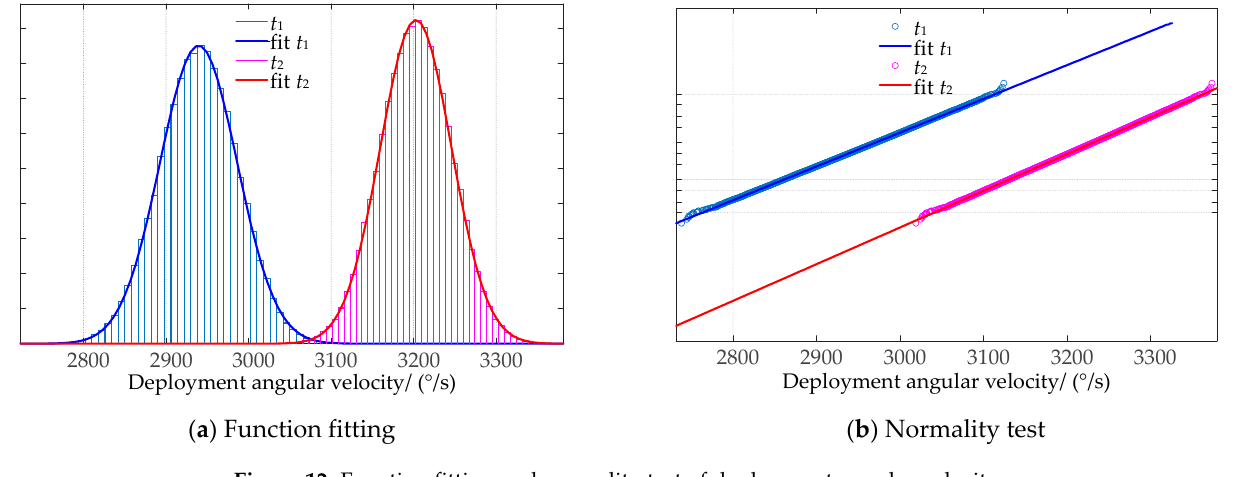
Figure 12. Function fitting and normality test of deployment angular velocity. It is obvious that all discrete data follow a normal distribution. The MC method is applied to validate the proposed method under specified conditions, and the reliability of the upper deployable mechanism R i is shown in Table 3. Furthermore, those of the lower mechanism are similar to the upper mechanism. method is proved.